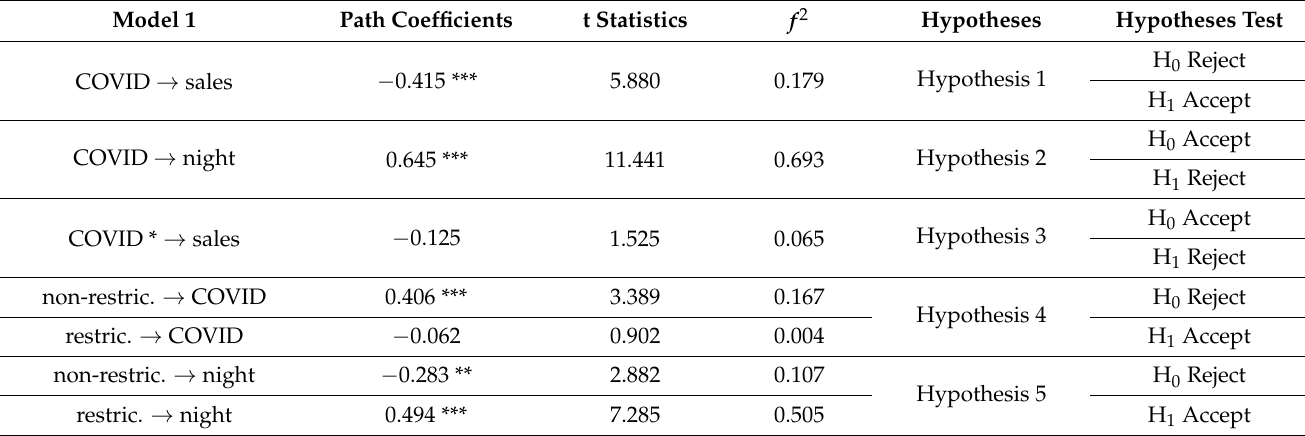
Table A1. Path and f 2 analysis